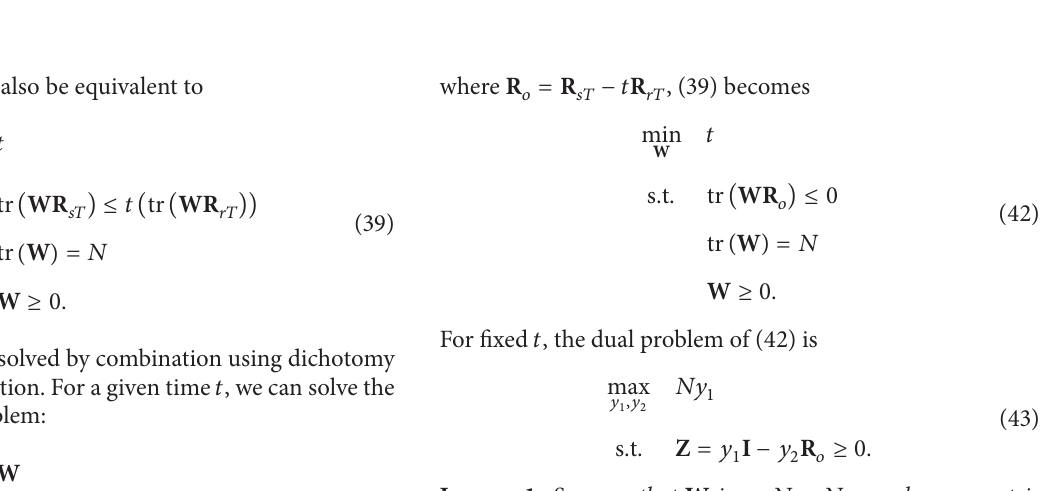
Algorithm 1: Rank-1 constrained solution procedure to solve the rank-one